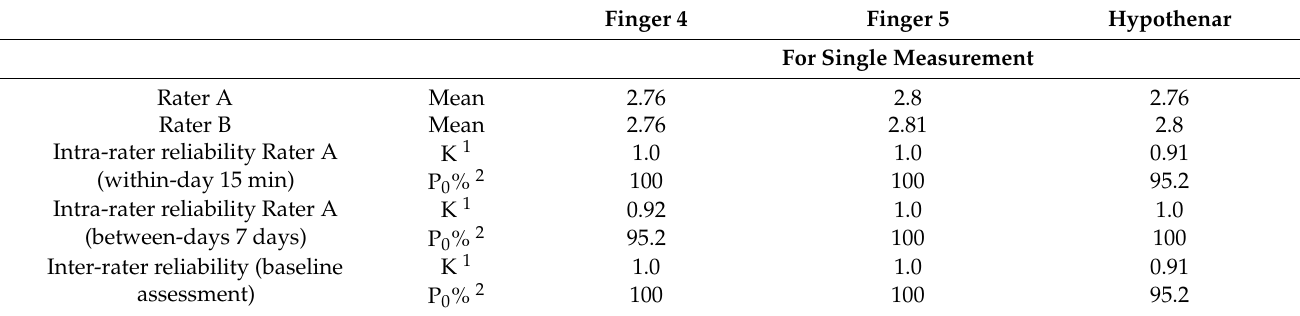
Table 2. Reliability and validity of Semmes–Weinstein monofilament (SWM) test—CuTS patients (n = 21).